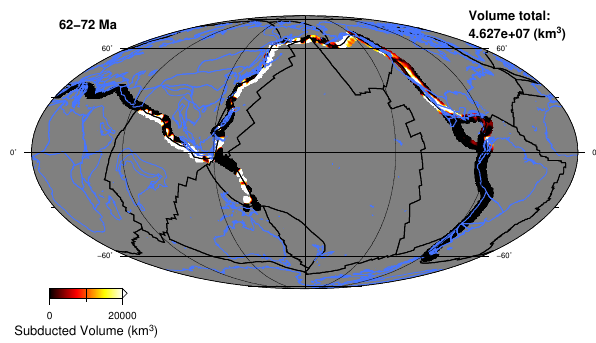
Figure B4. Integrated volume of subducted material between 72 and 62Ma. The colour scale represents the volume of material. The total amount of material for this time period is 4 . 6 × 10 7 km 3